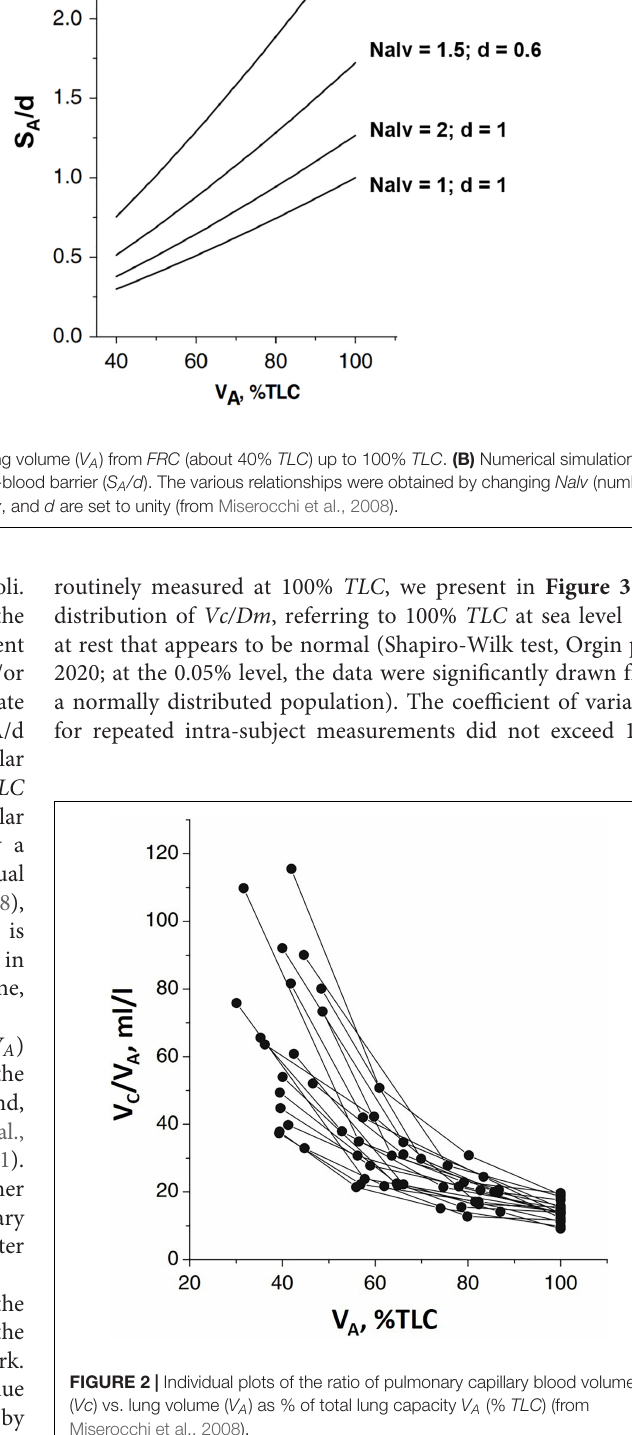
FIGURE 2 | Individual plots of the ratio of pulmonary capillary blood volume ( Vc ) vs. lung volume ( V A ) as % of total lung capacity V A (% TLC ) (from Miserocchi et al.,